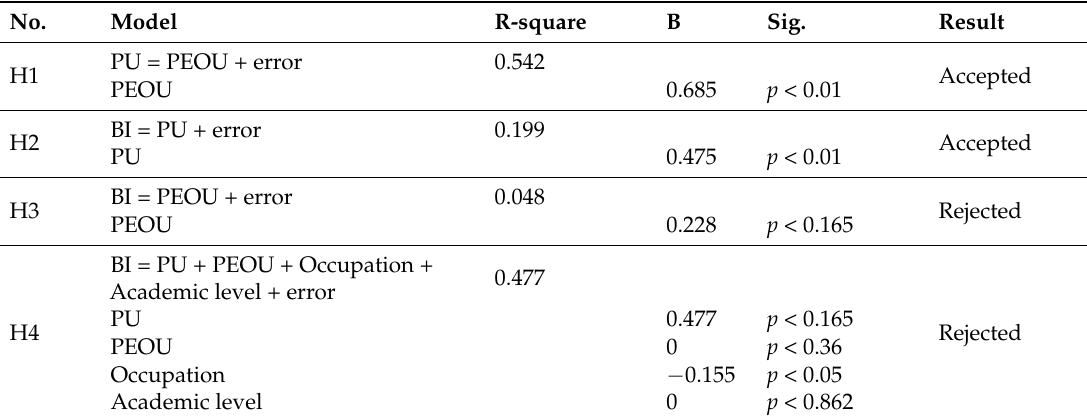
Table A8. Results of hypotheses testing (H1, H2, H3, H5).